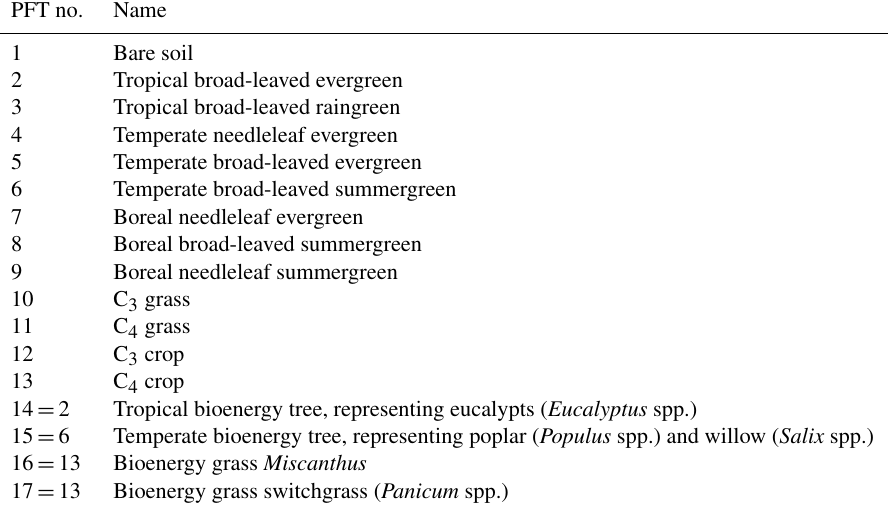
Table 1. Plant functional types (PFTs) in ORCHIDEE. The newly added bioenergy PFTs (PFT14 to PFT17) use the default setting of the original PFTs (all processes except harvest, see Sect. 2.2) but with new parameterizations (see Sect. 2.3). PFT